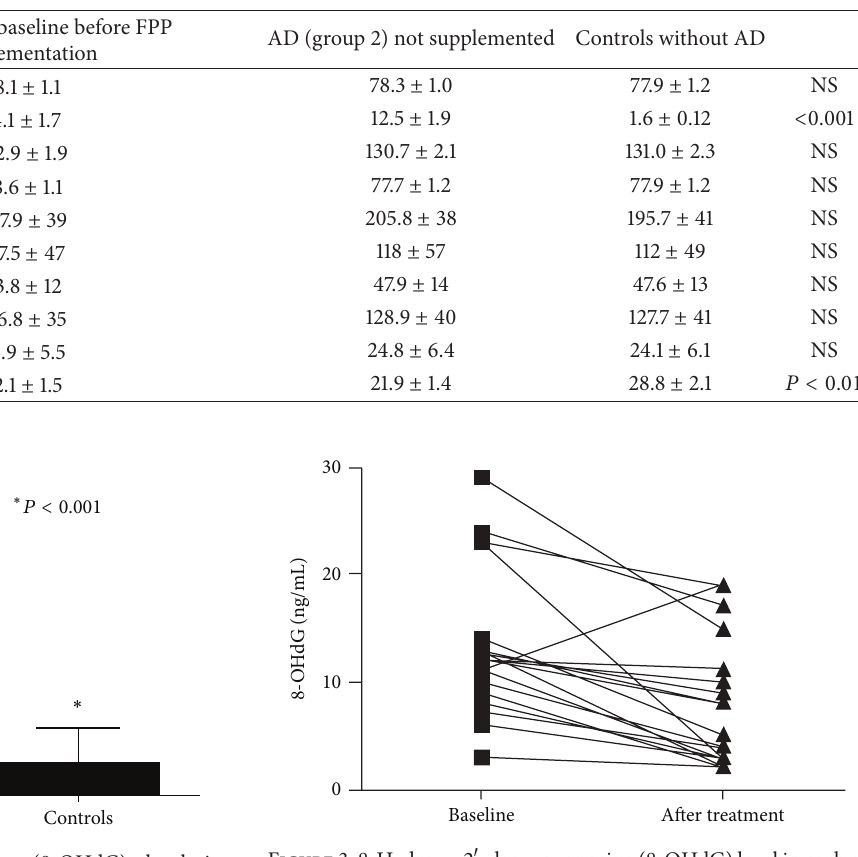
Figure 1: 8-Hydroxy-2 󸀠 -deoxyguanosine (8-OHdG) level in patients with Alzheimer’s disease and in controls.